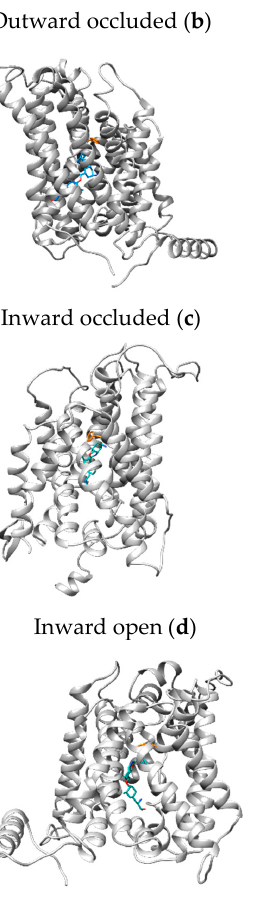
Figure 6. Docking analysis of the inhibitor JPH203. The figure shows the position of JPH203 (in cyan) in the four different conformations ( a – d ) and the residue F252 (in orange), the most crucial for the interaction with the inhibitor; the zoom of the binding site regions in the outward-open ( e , f ), outward-occluded ( g ) inward-occluded ( h ) and inward-open ( i ) conformations with the residues involved in the interactions (in yellow), among which is F252 (in orange); 2D view from Maestro of the residues predicted to interact with JPH203 in the different conformations ( e’ – i’ ).